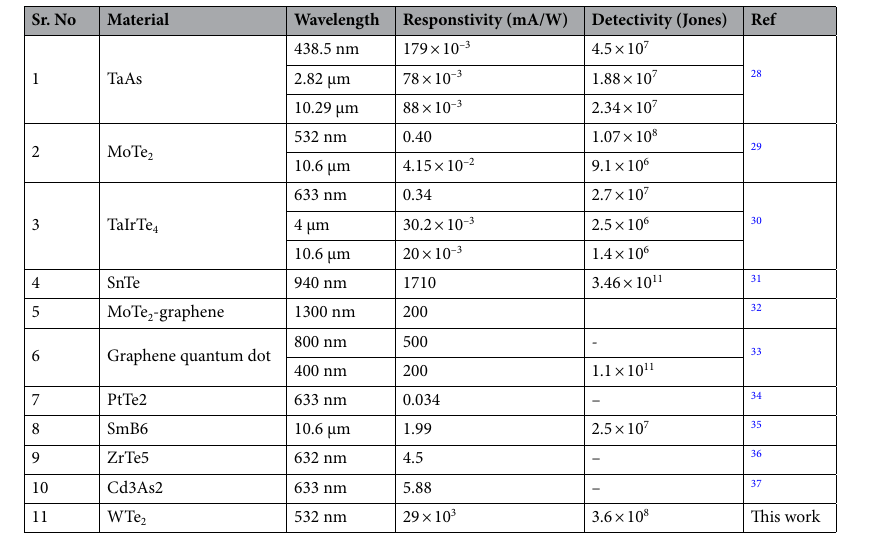
Table 1. Semimetals or Weyl materials based